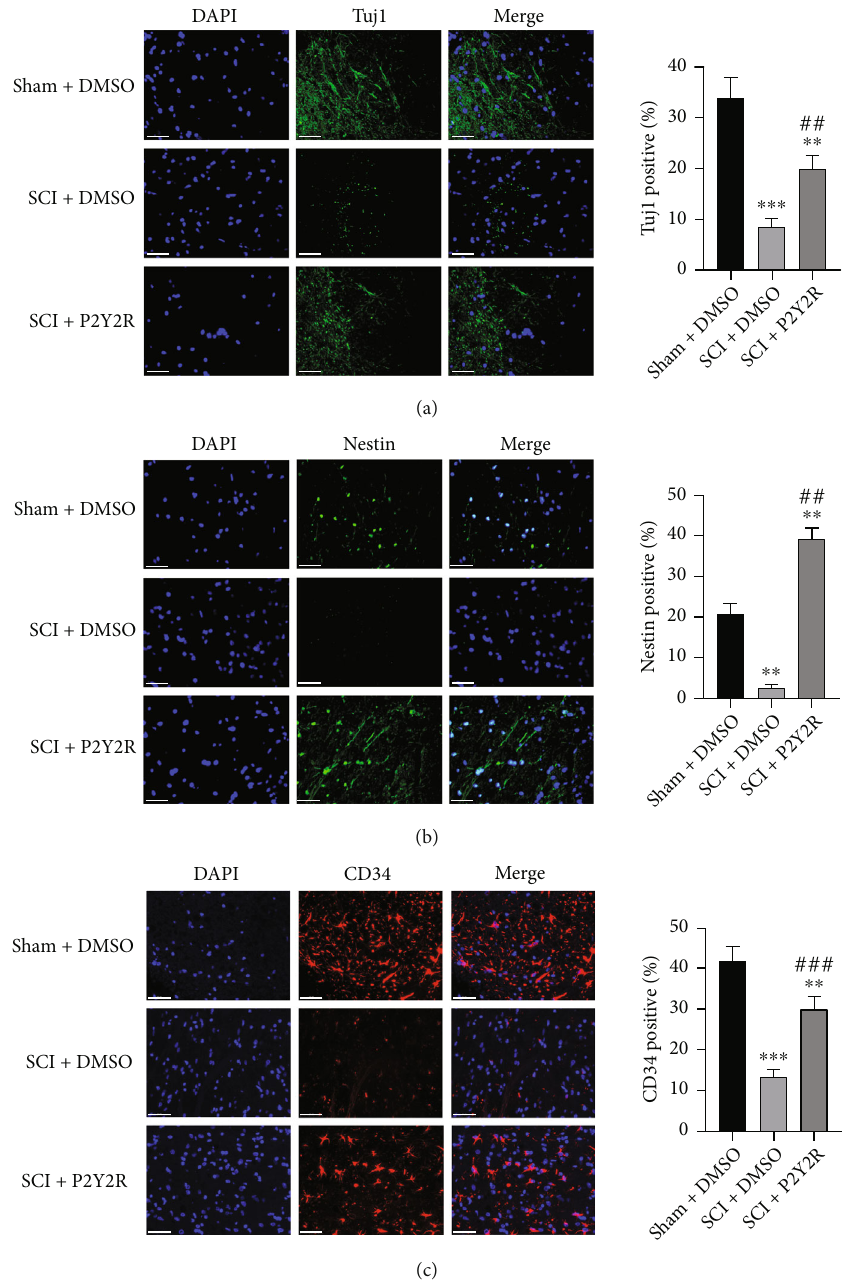
Figure 6: The expression levels of Tuj1, nestin, and CD34 detected by immuno fl uorescence staining. Scale bar = 50 μ m. ∗ p < 0 : 05 and ∗∗ p < 0 : 01 compared with the sham+DMSO group; # p < 0 : 05 and ## p < 0 : 01 compared with the SCI+DMSO